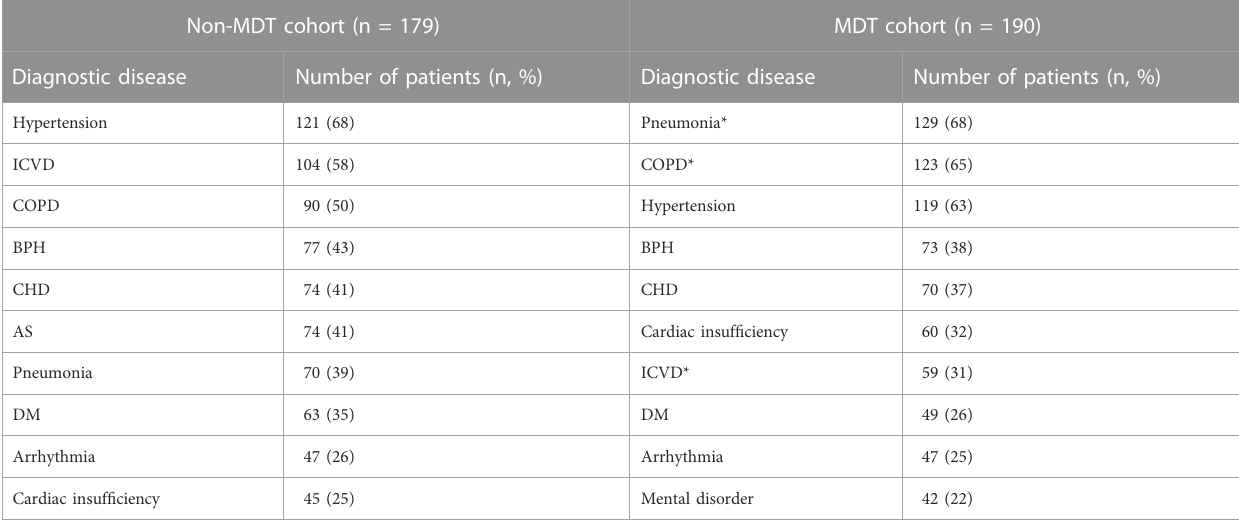
TABLE 2 Top ten diagnostic diseases in the MDT cohort and non-MDT cohort. Non-MDT cohort (n = 179) MDT cohort (n = 190) Diagnostic disease Number of patients (n, %) Diagnostic disease